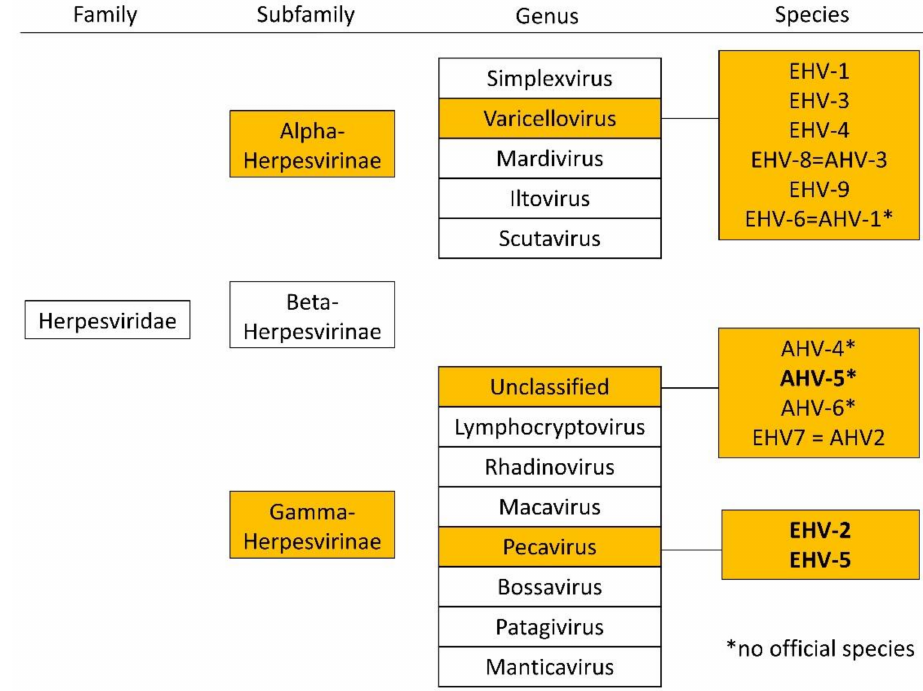
Figure 1. Overview of the family of Herpesviridae and relevant subfamilies, genera, and species in horses according to the international committee on the taxonomy of viruses (ICTV), status July 2021. Equid gammaherpesviruses detected in this study are highlighted in